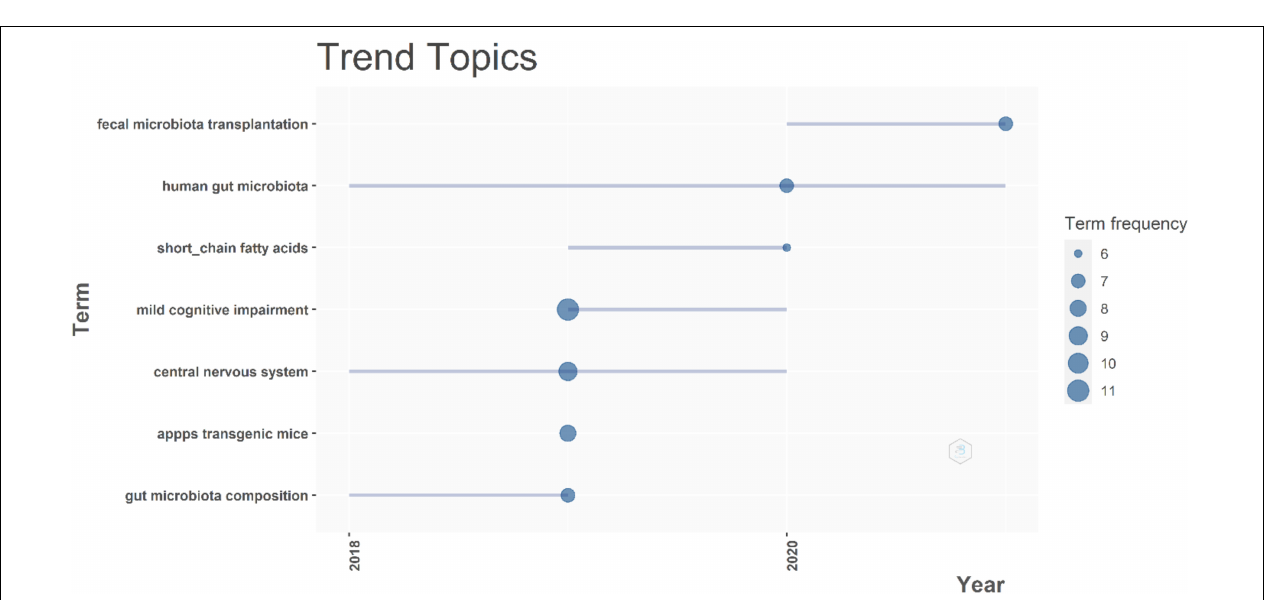
FIGURE 7 | Trending topics. On the x -axis, we have the time span in years, on the y -axis, the list of trending topics. The size of the circle indicates the frequency of the term, the position of the circle marks the year with most publications on that topic, and the line defines how long that term has been present.